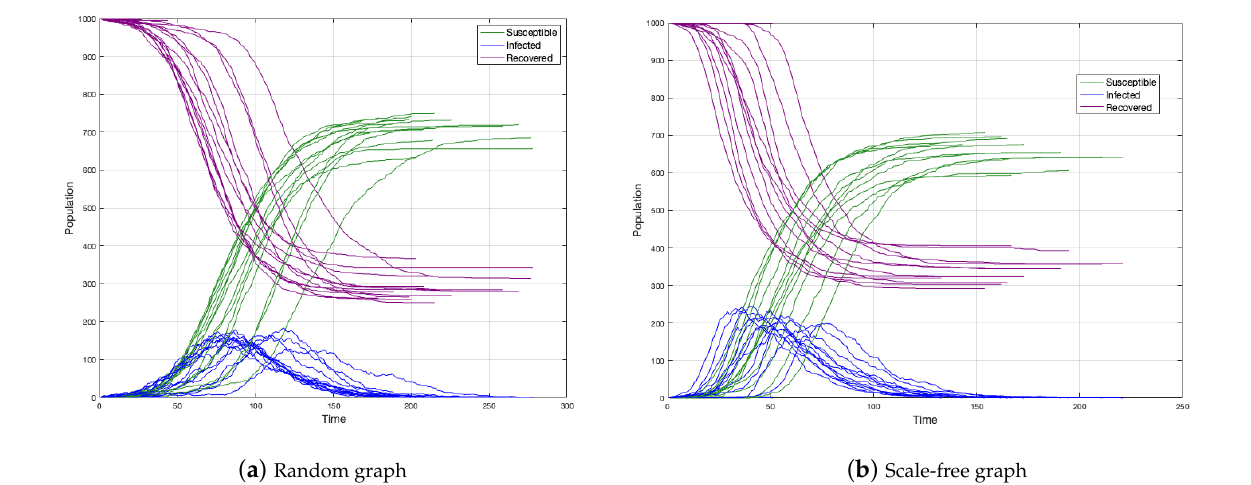
Figure 3. Epidemic spreading on random and scale-free graph